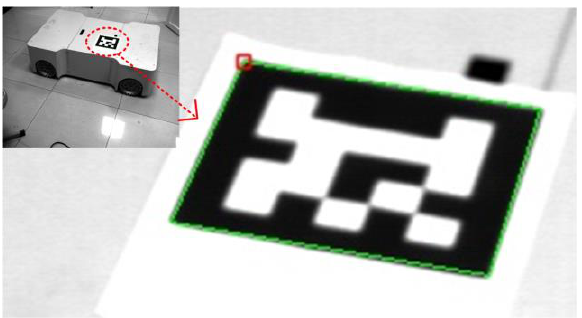
Figure 5. Monocular camera localization recognition effect.